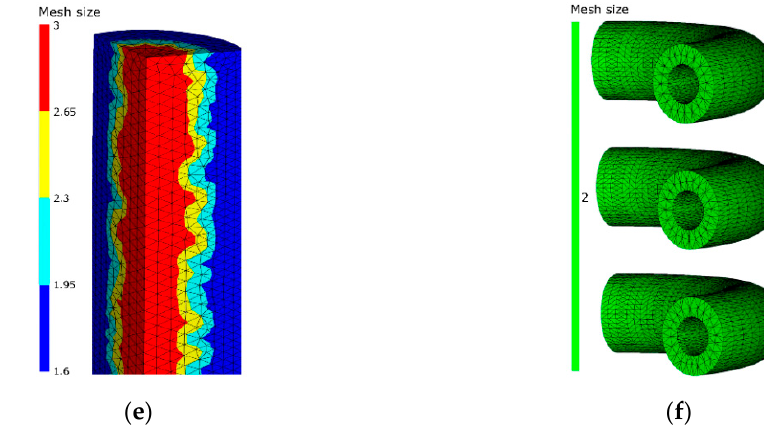
Figure 3. Initial set-up of induction heating: 3D model (Forge NxT) ( a ); detail of mesh of 3D model ( b ); 2D model (Ansys-Maxwell) ( c ); detail of mesh of 2D model ( d ). Closer details of the 3D models of heated workpiece ( e ) and the inductor coil ( f ).